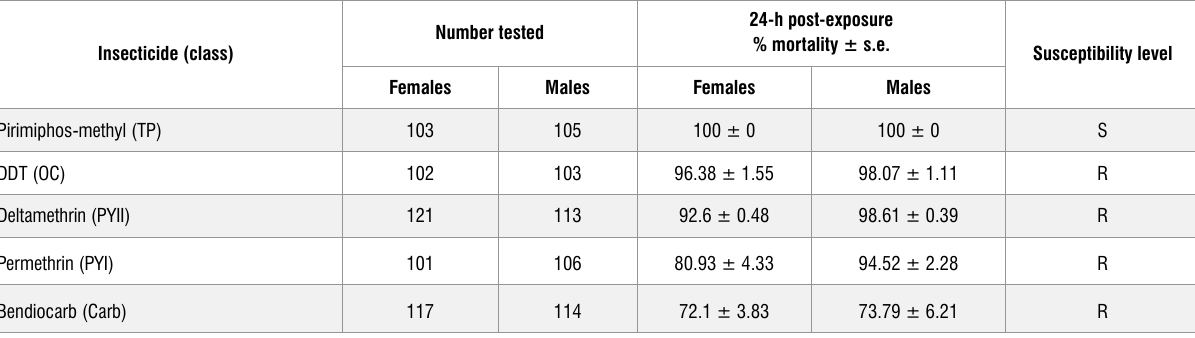
Table 3: Insecticide (permethrin and bendiocarb) susceptibilities of F1 Anopheles arabiensis with or without pre-exposure to the P450 synergist piperonyl butoxide (PBO) or the general esterase synergist triphenyl phosphate (TPP). Mean mortalities (%), standard errors (s.e.) and sample sizes ( n ) are given by Mamfene section (S2, S8, and S9), northern KwaZulu-Natal Province, South Africa, 2019–2021 S2 S8 Treatment % mortality ± s.e. ( n